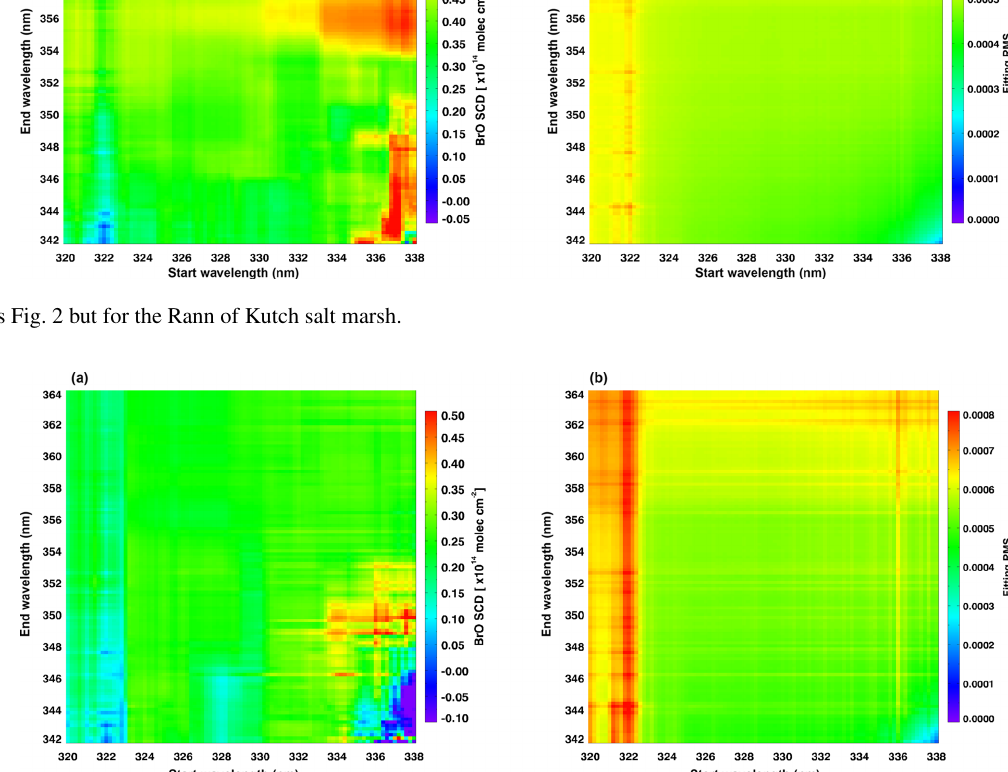
Figure 5. As Fig. 2, but for the selected volcanic plume